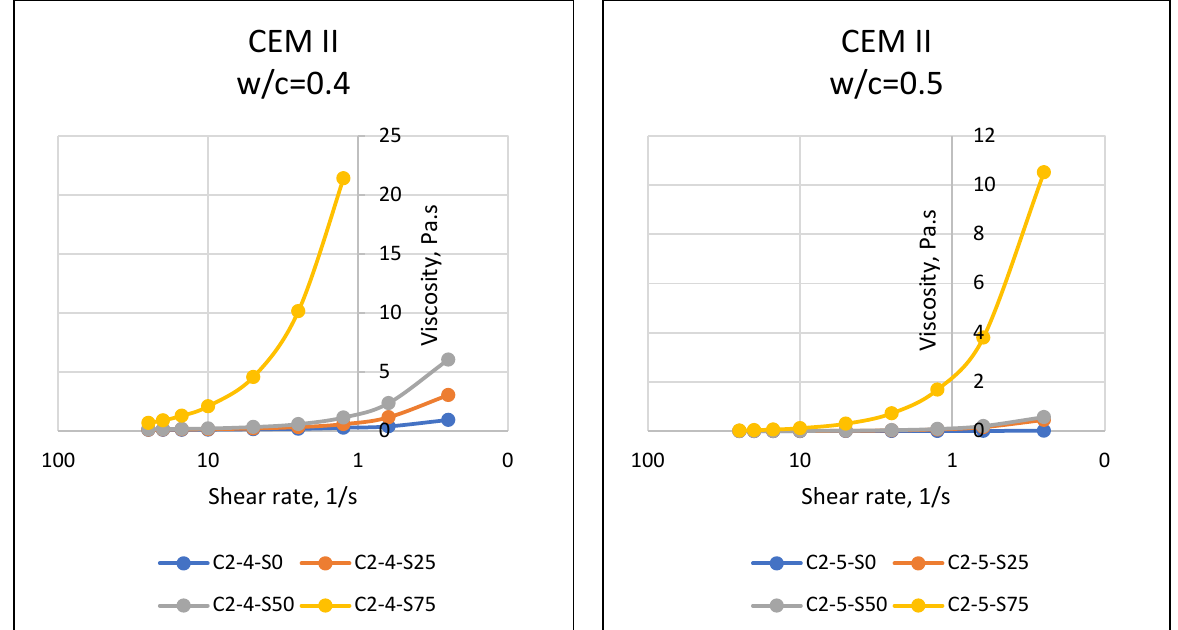
Figure 3. Viscosity–Shear Rate Relationships of SAPCPs with CEM II (w/c = 0.40 and 0.50).